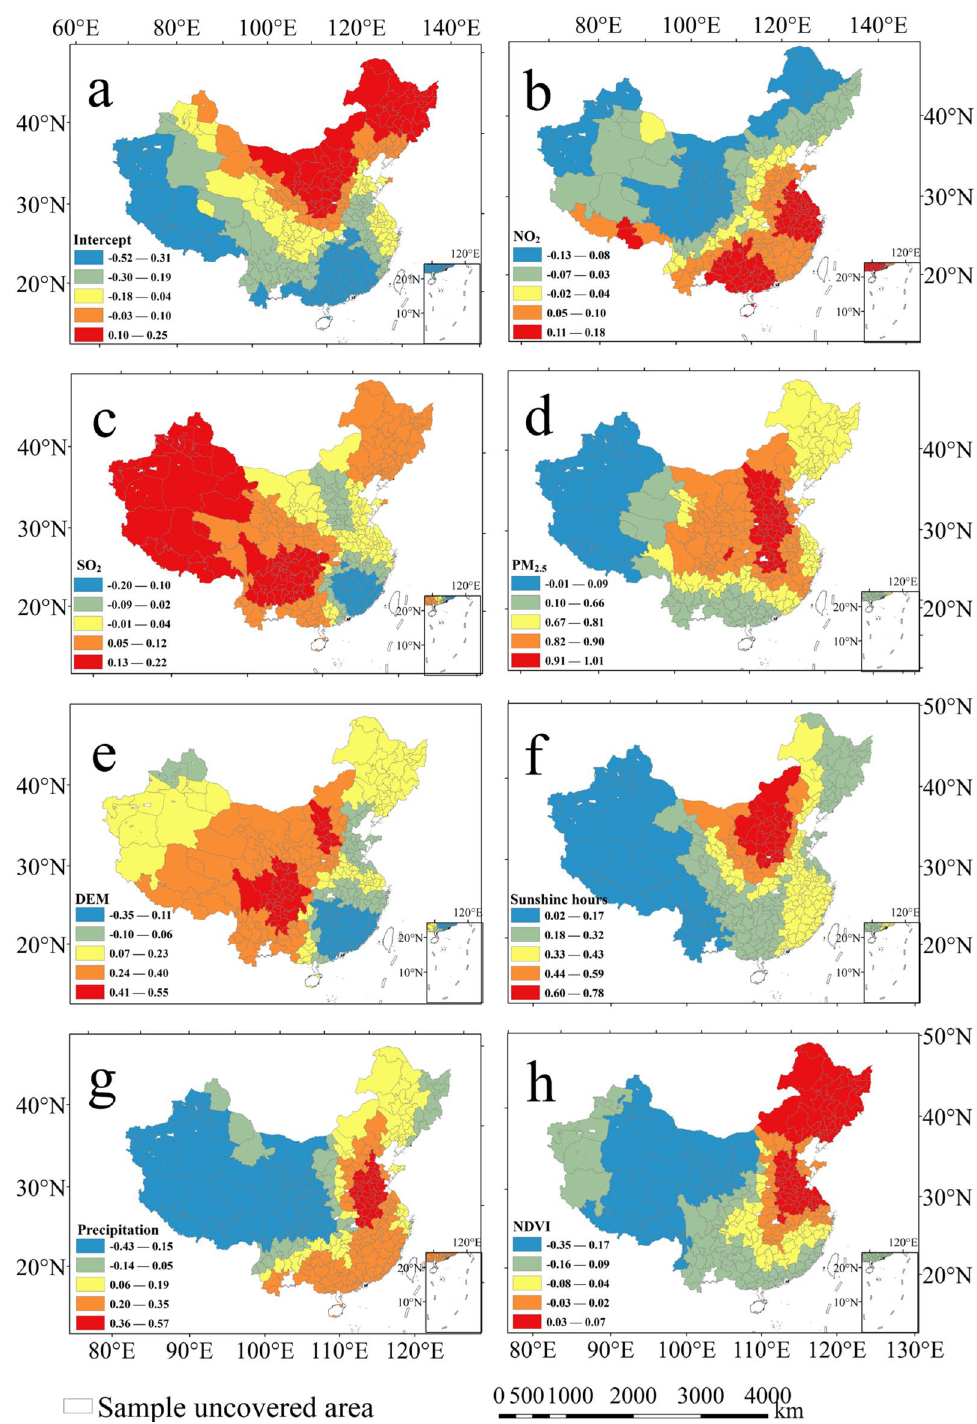
Figure 6. Spatial patterns of coefficients in the MGWR. ( a ) Intercept, ( b ) NO 2 , ( c ) SO 2 , ( d ) PM 2.5 , ( e ) DEM, ( f ) sunshine hours, ( g ) precipitation, ( h ) NDVI.